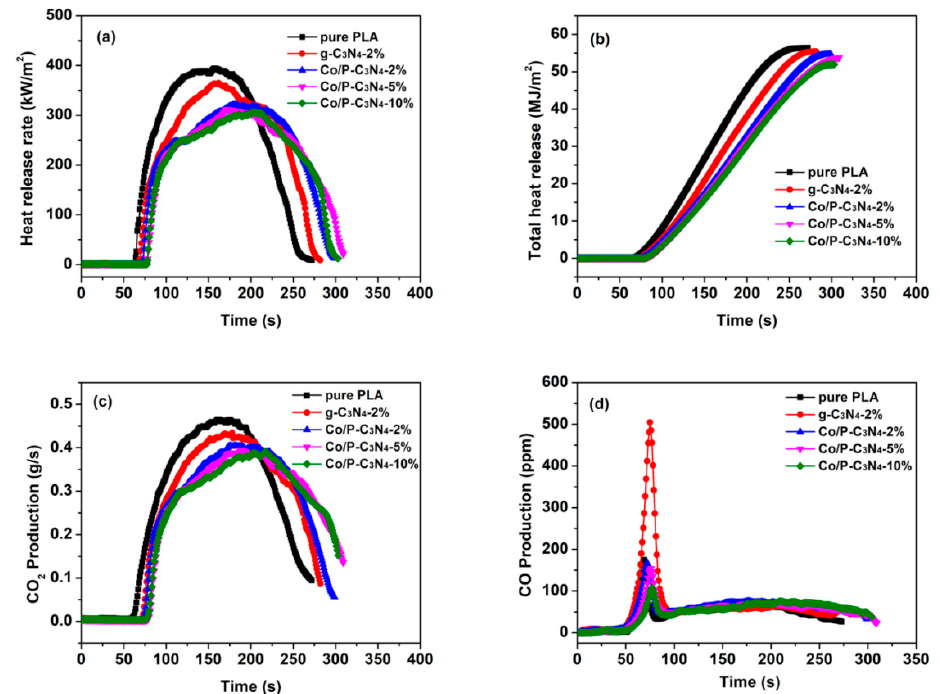
Figure 6. Cone calorimeter test results of pure PLA and PLA composites: ( a ) heat release rates, ( b ) total heat release, ( c ) CO 2 production rate, and ( d ) CO production rate as a function of time. Table 4. Combustion results of control PLA and its composites obtained from cone calorimeter tests.